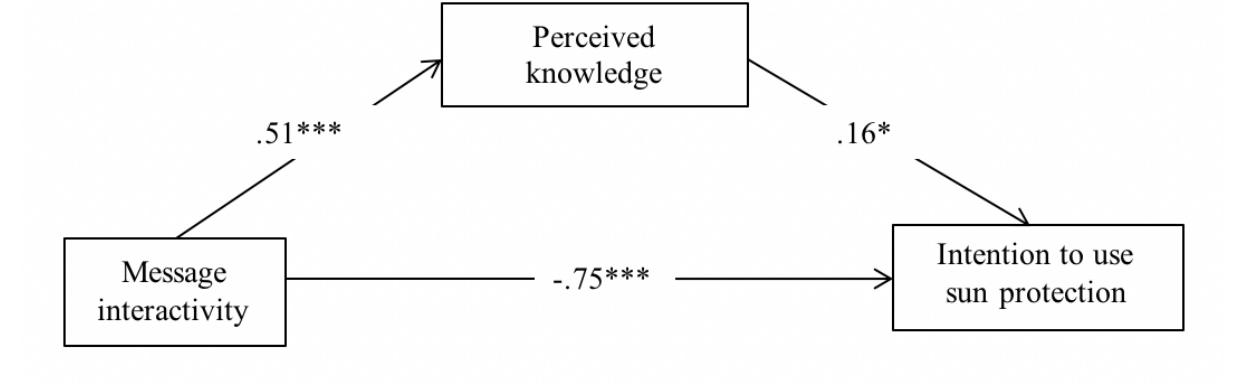
Figure 5. Mediation model of message interactivity on intention through attitudes, including effects of control variables (age, sex, race, and education, which are not displayed). * P <.05; ** P <.01; *** P